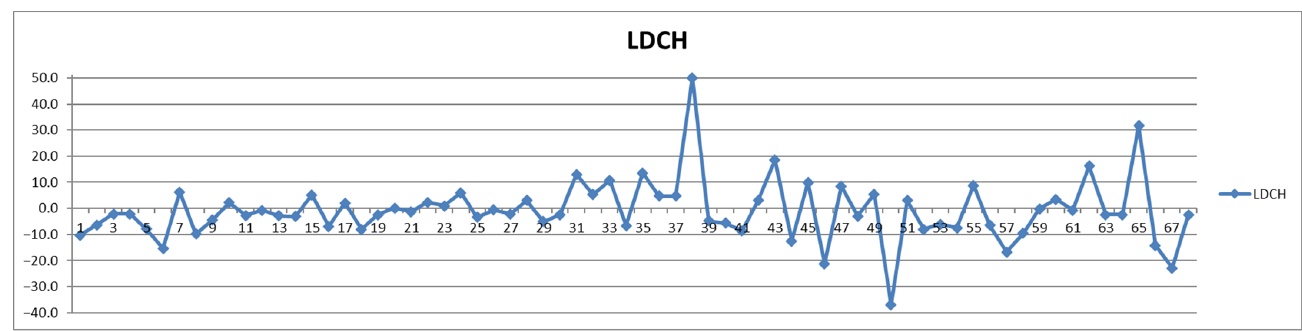
Figure 9. LDL cholesterol (LDCH) concentrations (mg/dL) in fasting (blue) and postprandial (red) status for control cases (1–29) and CVD cases (30–68).